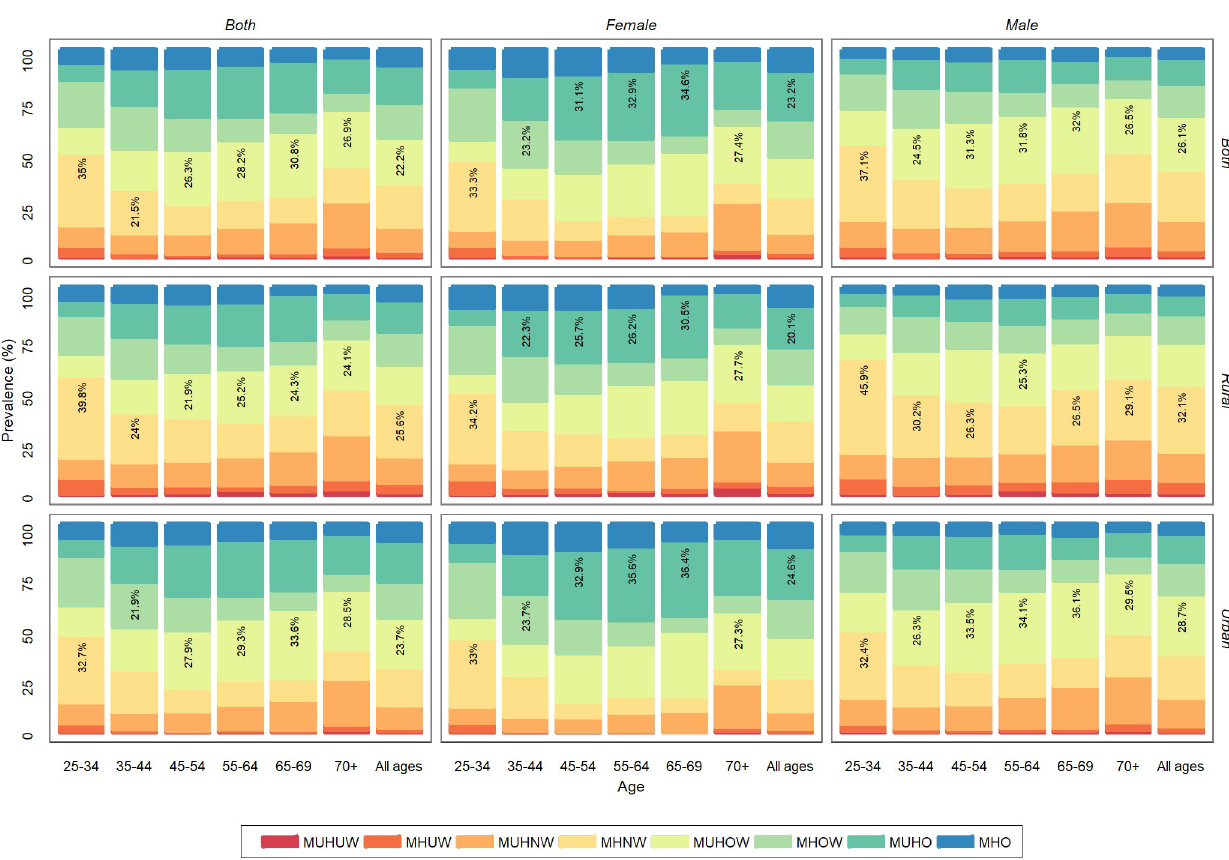
Fig 1. National prevalence of metabolic phenotypes for each BMI category by sex, area of residence, and age groups. MUHUW: metabolically unhealthy underweight, MHUW: metabolically healthy underweight, MUHNW: metabolically unhealthy normal weight, MHNW: metabolically healthy normal weight, MUHOW: metabolically unhealthy overweight, MHOW: metabolically healthy overweight, MUHO: metabolically unhealthy obese, MHO: metabolically healthy obese.